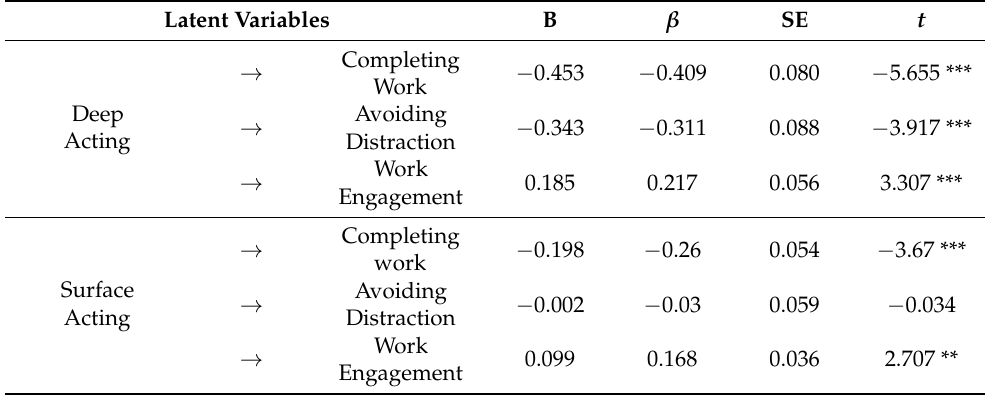
Table 5. Structural equation model